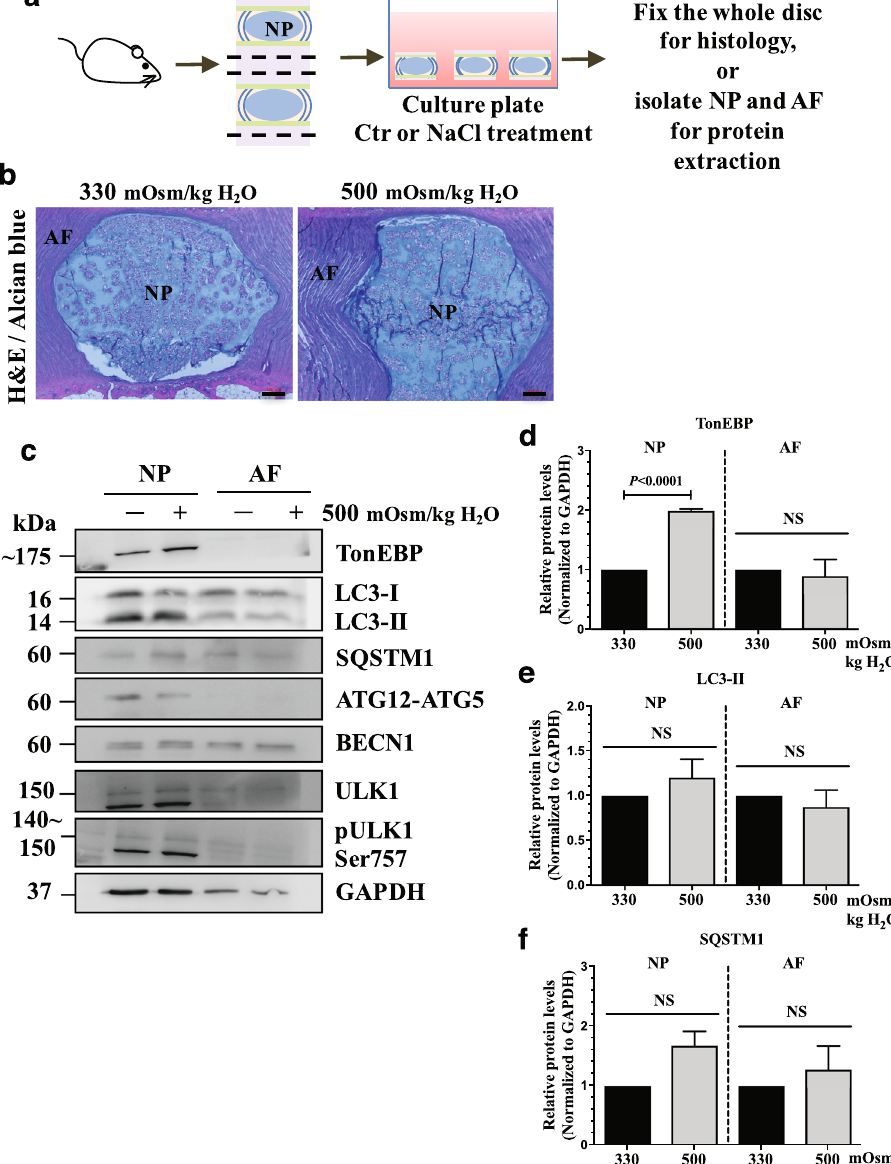
Figure 8. NP cells do not induce autophagy in response to hyperosmotic stimulus in an ex vivo disc organ culture model. ( a ) A schematic depicting ex vivo rat intervertebral disc organ culture model. ( b ) H&E and alcian blue staining of discs cultured under iso- (330 mOsm/kg H 2 O) or hyperosmotic (500 mOsm/kg H 2 O) conditions showing that NP maintained its structure and cellular morphology. Scale bar: 100 μ m. ( c ) Western blot analysis of tissue proteins from NP or AF (annulus fibrosus) compartments of the organ culture discs. The level of TonEBP increased with hyperosmotic stimulus only in the NP. However, the levels of LC3-II, SQSTM1, ATG12-ATG5, BECN1, as well as pULK1 Ser757 did not change with hyperosmolarity in both NP and AF. ( d – f ) Densitometric analyses of multiple Western blots represented in ( c ). Bars represent mean ± SEM (n = 3; For each independent experiment, one motion segment per group was used for histology and 6 motion segments per group were used for tissue protein Western blot). Student t test was used to determine statistical significance. NS, non-significant. Western blot images were cropped and acquired under same experimental conditions. See Supplementary Fig. S1 for examples of uncropped